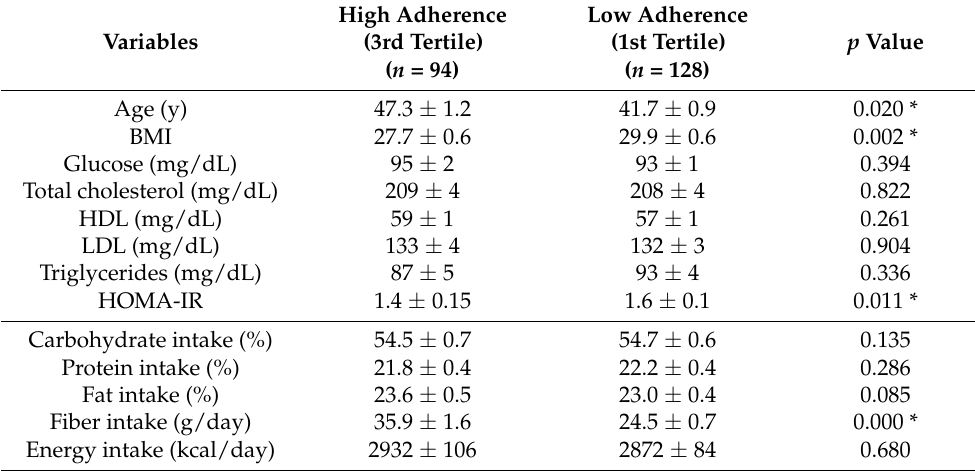
Table 1. Baseline characteristics of the population separated by adherence to the MD (Mediter- ranean